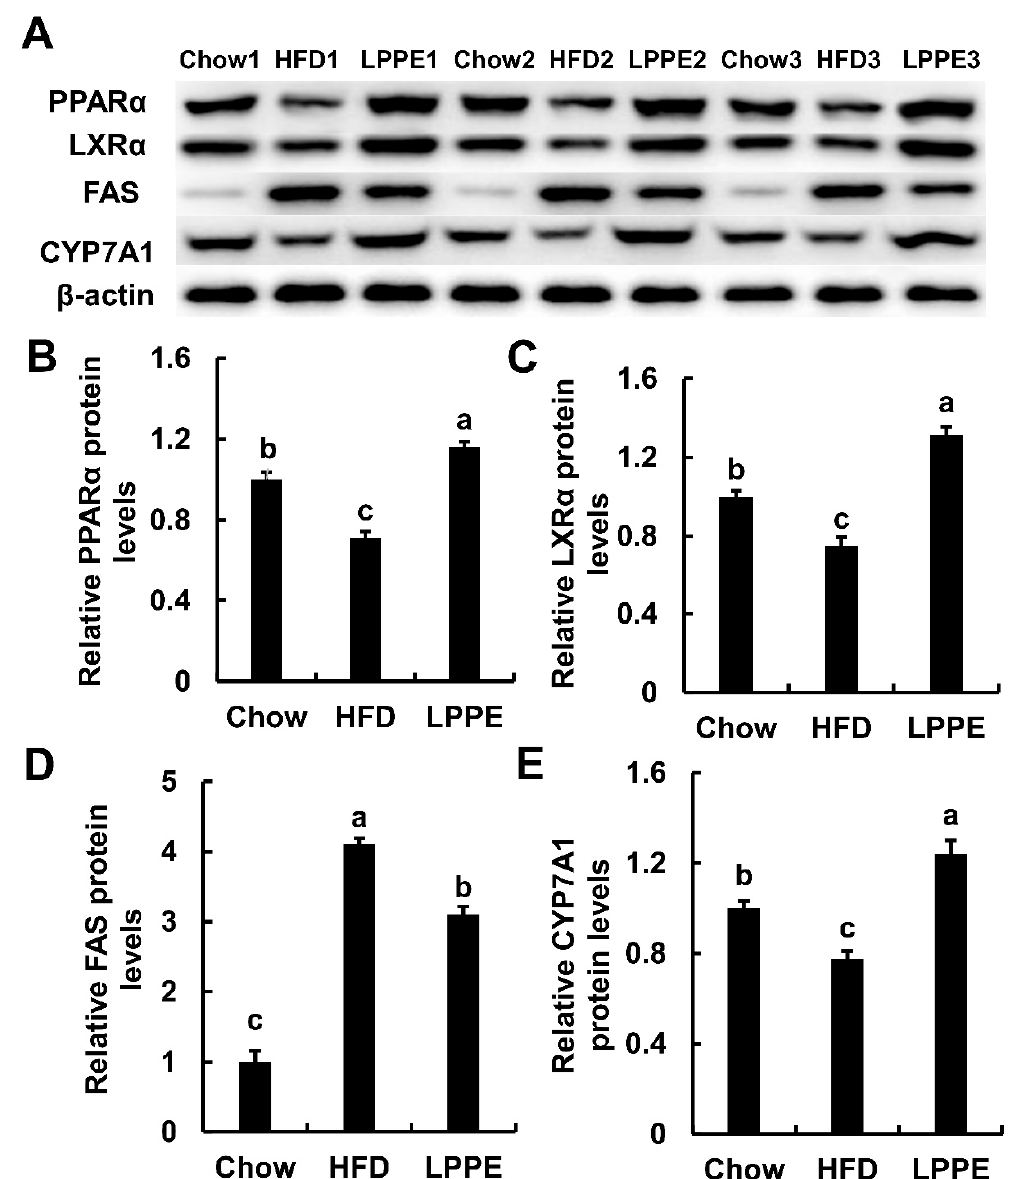
Figure 5. Effects of LPPE on the protein expressions involved in lipid metabolism. The Western blot photos ( A ). The relative PPAR α protein levels ( B ). The relative LXR α protein levels ( C ). The relative FAS protein levels ( D ). The relative CYP7A1 protein levels ( E ). Values are expressed as mean ± SEM (n = 3). Different letters indicated significant differences ( p < 0.05).